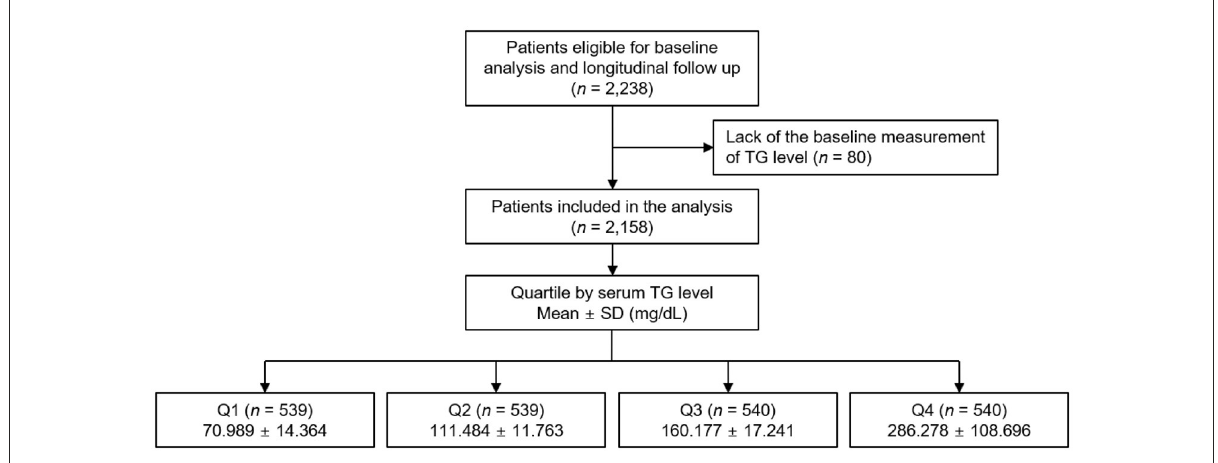
FIGURE1 Flow diagram of the study participants. SD, standard deviation; TG, triglyceride; Q1, 1st quartile; Q2, 2nd quartile; Q3, 3rd quartile; Q4, 4th